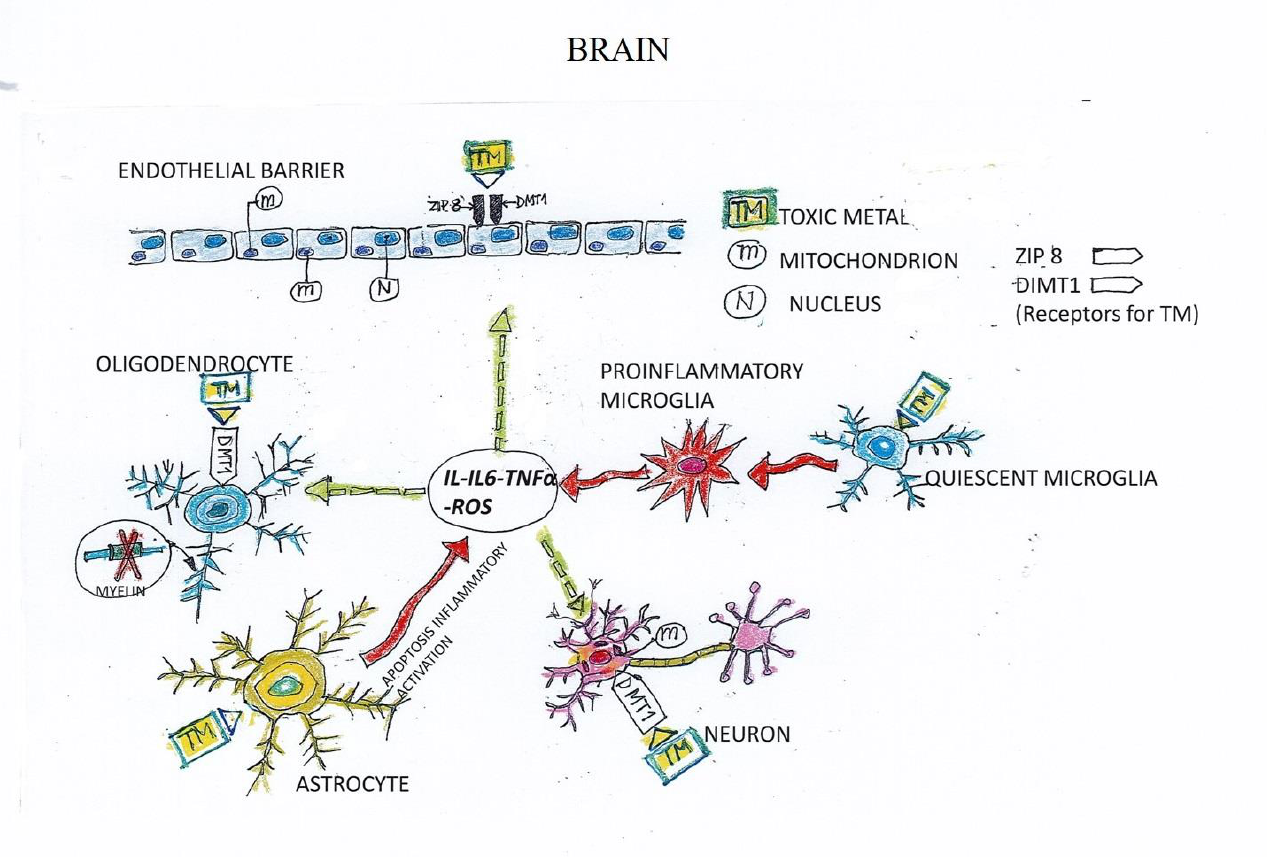
Figure 1. Mechanisms of toxic-metal-inflicted damage on neurological and endothelial cells. TMs cross the endothelial barrier by exploiting the ZIP 8 and DMT1 receptors ex- pressed by the endothelial lining. Then, TMs directly interact with the cellular components of the central nervous system, activating them and inducing a mitochondrial imbalance resulting in increased production of reactive oxygen species (ROS). Quiescent microglia are shifted toward a pro-inflammatory phenotype—characterized by high production of TNF- α , IL-1, and IL-6—that (dashed arrows) indirectly impairs oligodendrocyte myelin pro- duction and neuron viability, and promotes endothelial leakage, perpetuating the vicious cycle and the generation of a harmful